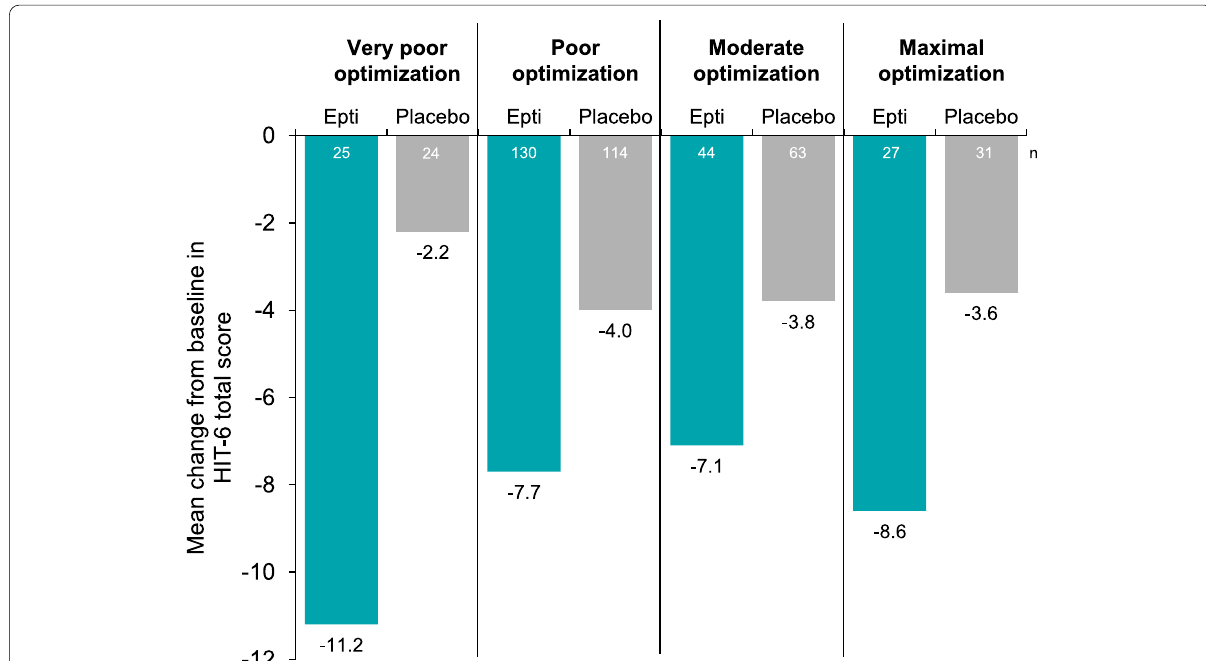
Fig. 4 Change from baseline to week 4 in HIT-6 total score by baseline acute treatment optimization subgroup based on mTOQ-4. Patients were grouped by baseline mTOQ-4 total scores into the following optimization categories: very poor (0), poor (1–5), moderate (6–7), and maximal (8). The HIT-6 total score ranges from 36 to 78, with higher scores indicating more severe headache-related impact. Epti, eptinezumab (100 mg); HIT-6, 6-item Headache Impact Test; mTOQ-4, 4-item Migraine Treatment Optimization